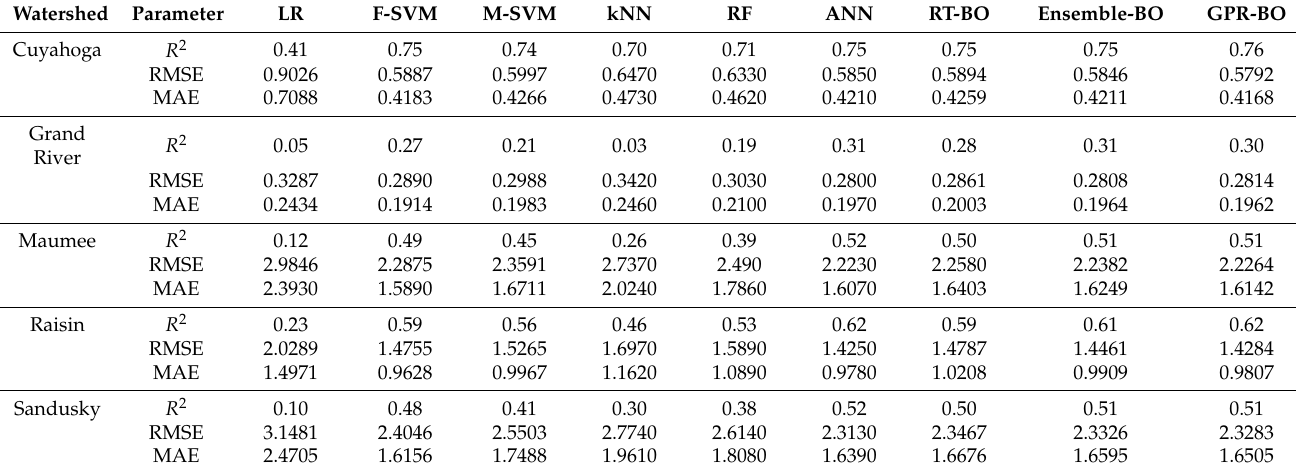
Table 2. Comparison of R 2 , RMSE, and MAE using different ML algorithms for nitrate prediction on training dataset. Watershed Parameter